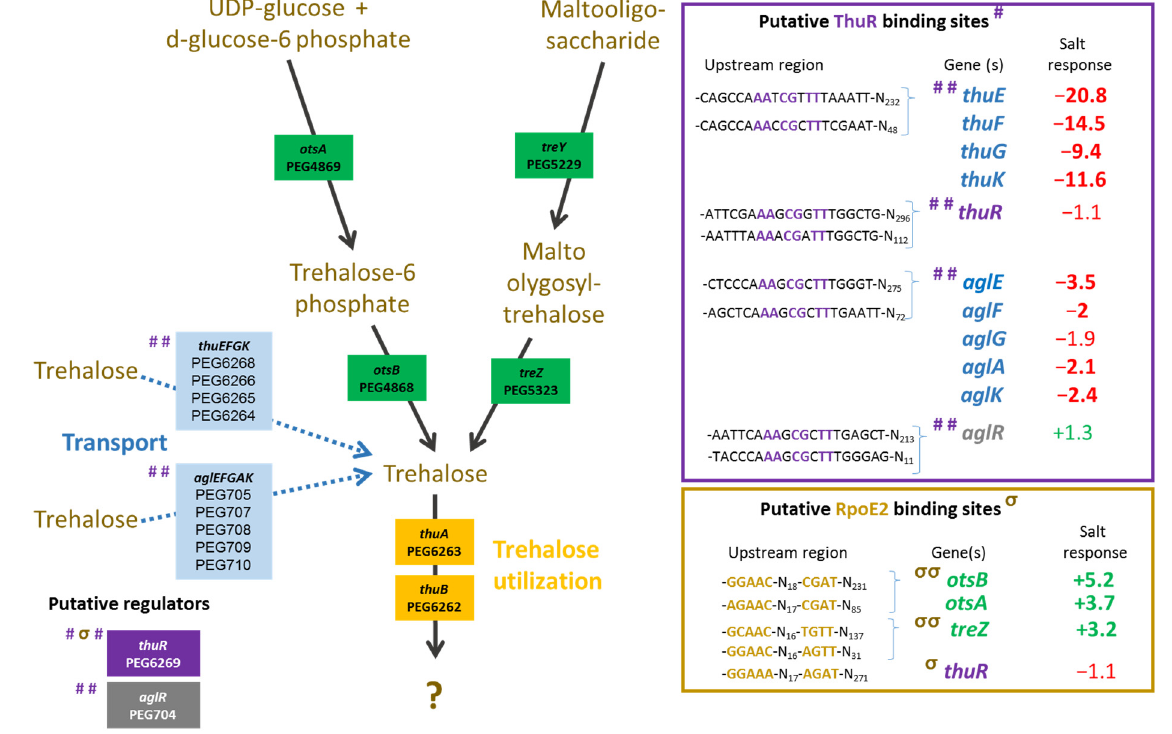
Figure 3. Metabolism of trehalose. Ensifer aridi predicted encoding genes (PEGs) involved in the metabolism and transport of trehalose are shown in the metabolic pathway. The presence of putative ThuR and RpoE2 binding sites upstream of genes (shown in the right boxes) are indicated by “#” and “ σ ”, respectively, on the left of genes when identified, and the position of conserved residues are bolded and colored accordingly in boxes. The salt response refers to fold change previously found by RNAseq [15]. Positive fold changes indicating upregulation (green) and negative ones showing repression (red) in salt containing medium are bolded when above 2.